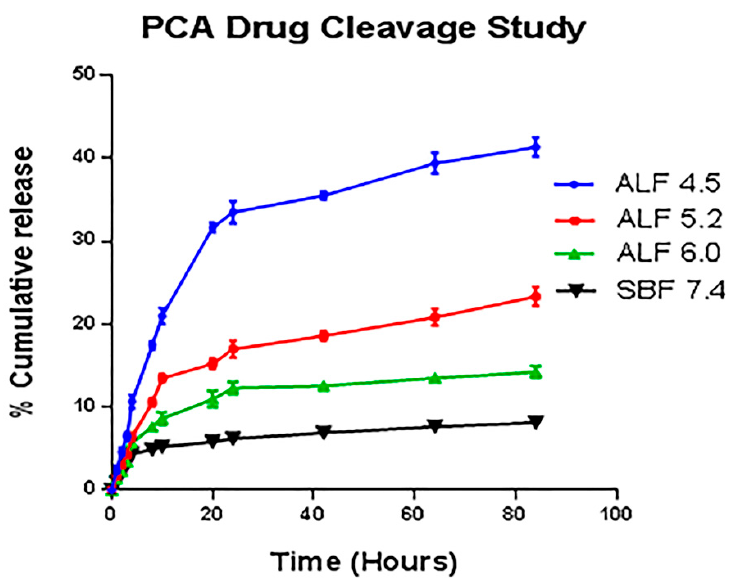
Figure 9. Release of PCA from MPIEDPCA conjugate in ALF media at different pH 4.5, 5.2, 6.0 and SBF 7.4.